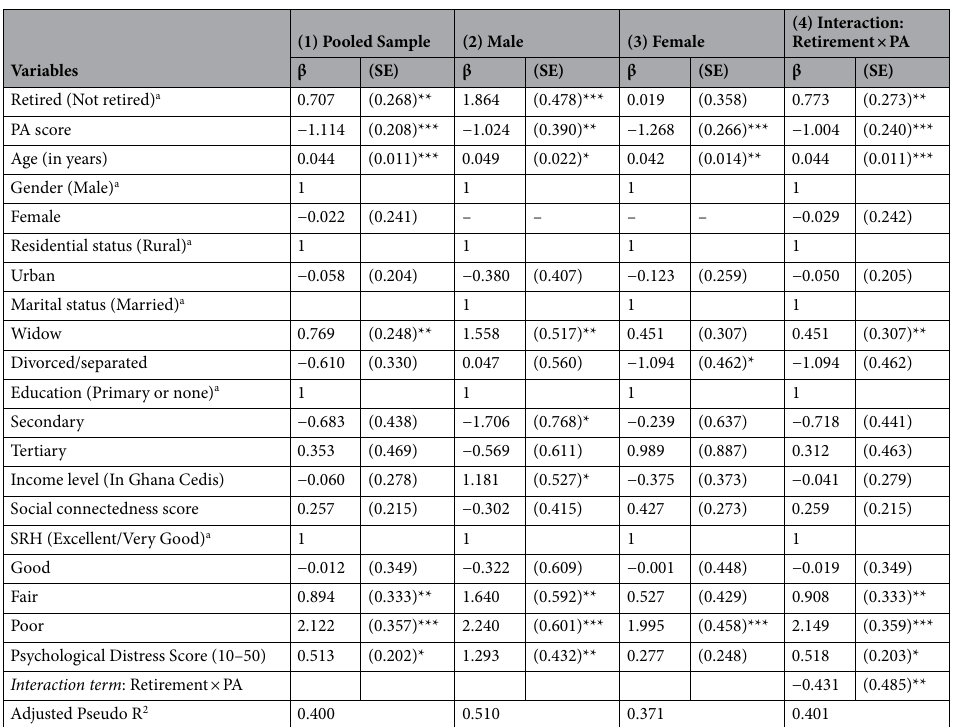
Table 5. Predicting FI Score with Retirement and PA Score among ≥ 65 age group: OLS Regression Models. β—Coefficients; SE—robust standard errors are presented in parentheses; FI—functional impairment;